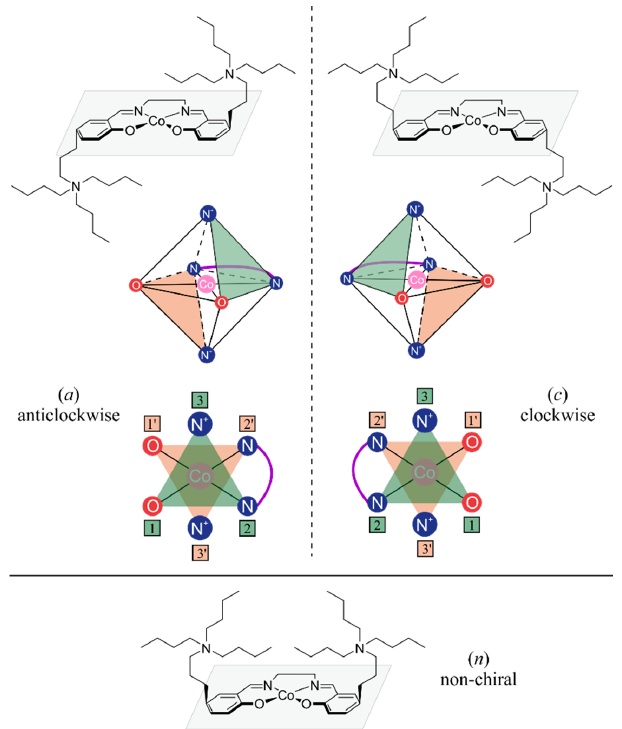
Figure A3. Spatial arrangement of cocatalyst units in organometallic cobalt complex with salen- type ligand adopting trans configuration. Resulting stereoisomerism—conformational isomers are classified only with respect to the placement of quaternary nitrogen atoms, neglecting other possible stereogenic units.